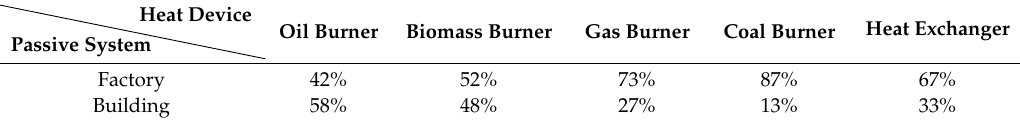
Table A4. The shares of heat flows into the factory and the building of China in 2015.